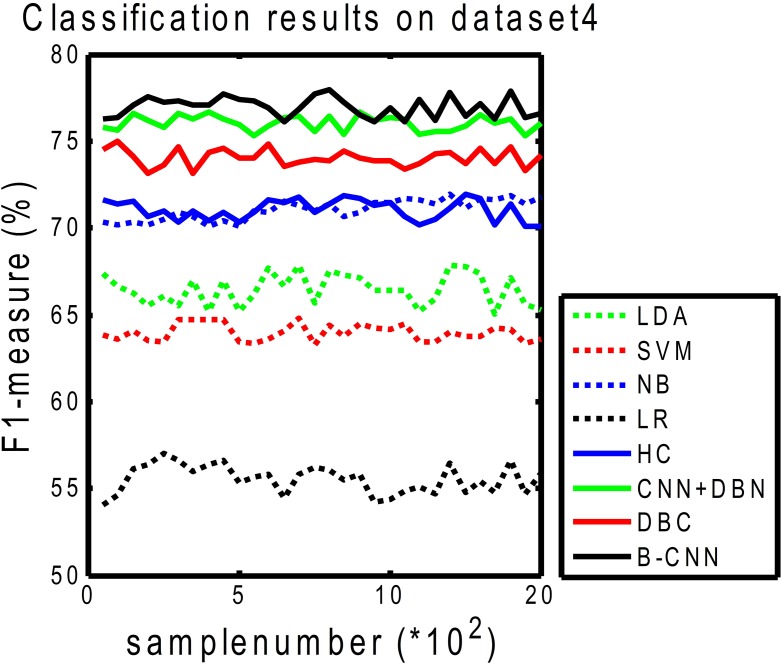
F1-measure curves on dataset 4 (C = 20).